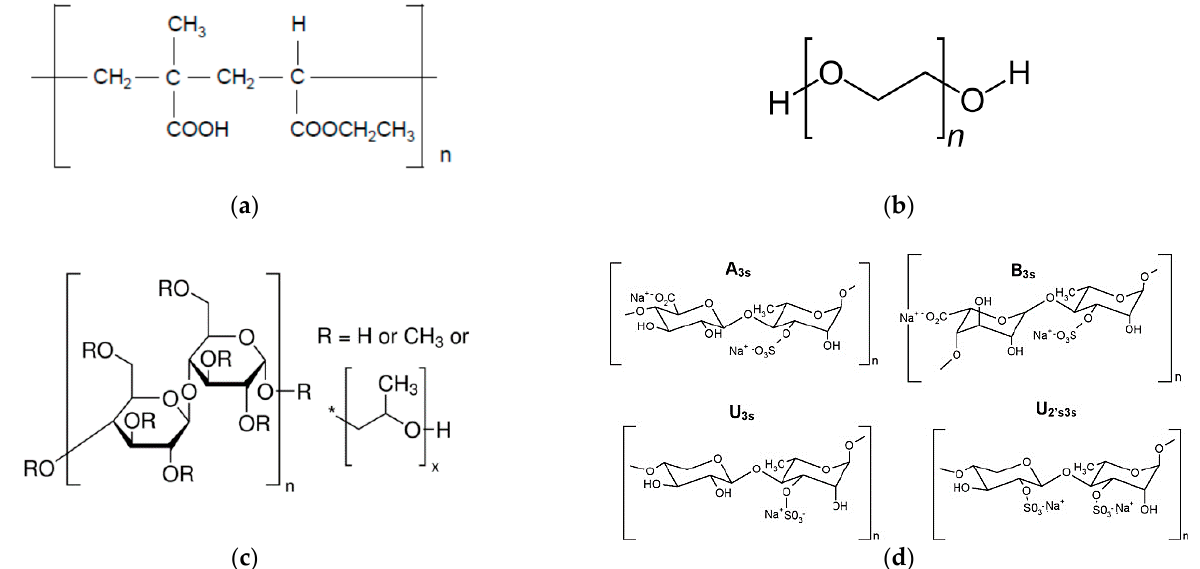
Scheme 2. Chemical structure of: ( a ) Eudragit ® L100-55, ( b ) poly(ethylene oxide) (PEO), ( c ) hydroxypropylmethycellulose (HPMC K15M) and ( d ) structure of the main repeating disaccharides in Ulva ulvan: ulvanobiuronic acids A 3S and B 3S and ulvanobioses U 3S and U 2 ′ S,3S [29].